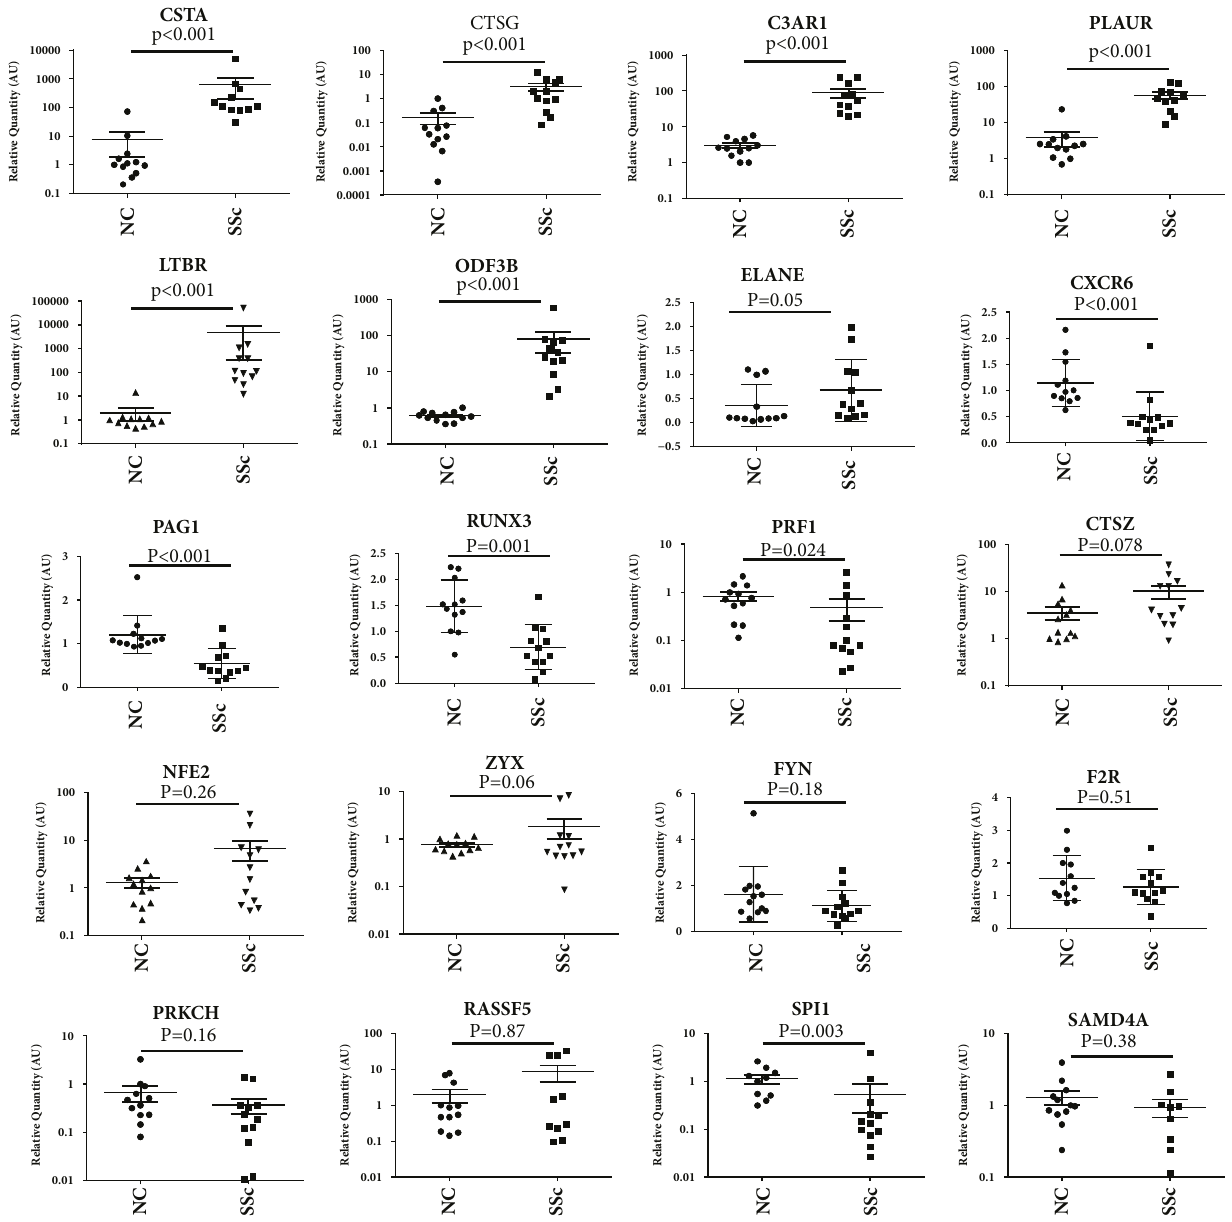
Figure 4: QPCR validation of gene expression: 20 Me D EGs were validated by QPCR in a separate cohort of SS c (n=12) and NC (n=12) samples. 11 MeDEGs (7 upregulated and 4 downregulated) were confirmed to be differentially expressed between SSc and NC ( p < 0.05) by QPCR and 6 MeDEGs (3 upregulated and 3 downregulated) showed the difference in expression but did not reached statistical significance. Inconsistency in the detection of the expression for three MeDEGs by microarray or QPCR was also